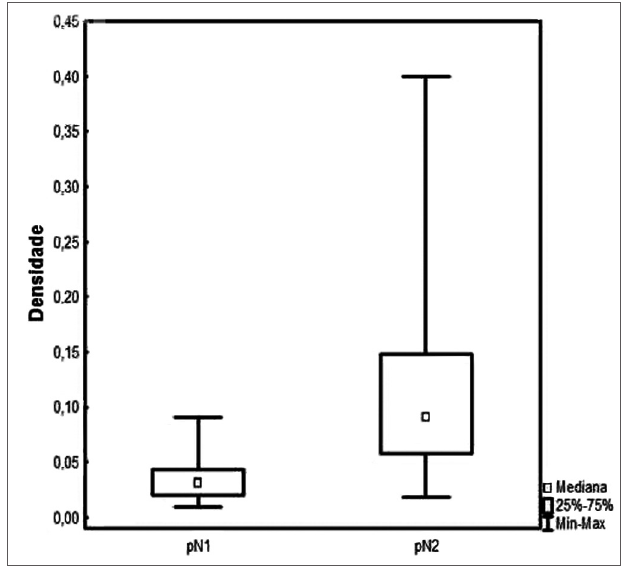
Figura 1. Densidade linfonodal de acordo com o estadiamento pN.